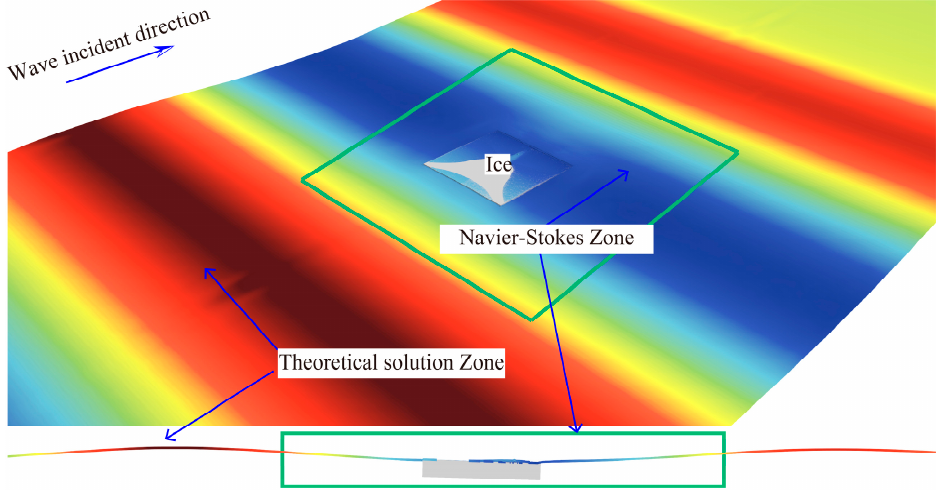
Figure 2. Illustration of the Euler overlay method. Wave forcing is achieved by adding a source term to the transport (momentum) equations expressed as: where γ , ρ , φ , and φ ∗ represent the forcing coefficient, fluid density, current solution of the transport equation, and value towards which the solution is forced, respectively. The forcing coefficient varies smoothly from zero at the inner edge of the forcing zone to the maximum value γ at the boundary (the outer edge of the forcing zone). x * is the relative coordinate within the forcing zone.